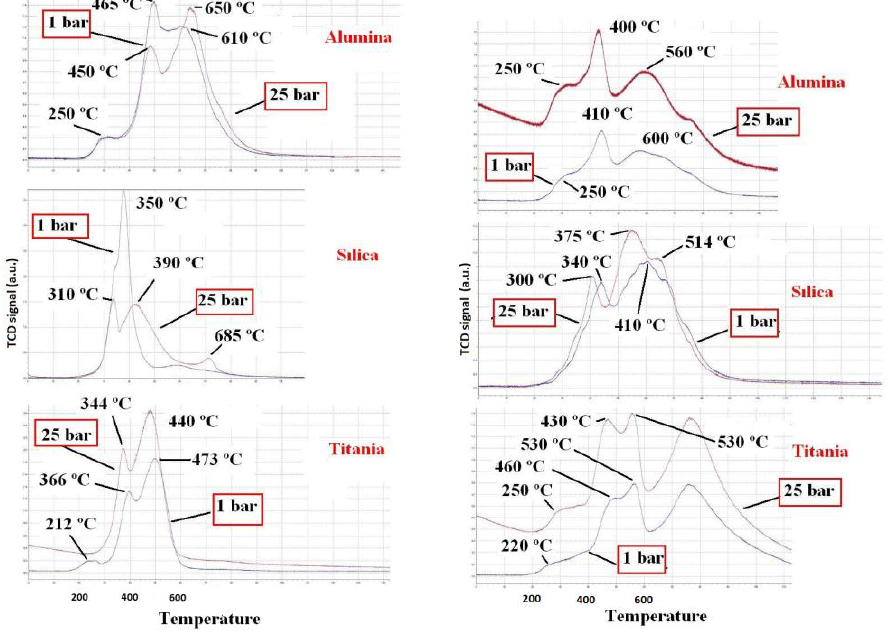
Figure 4. Reduction profiles corresponding to the supported cobalt ( left ) and iron ( right ) oxide catalysts.